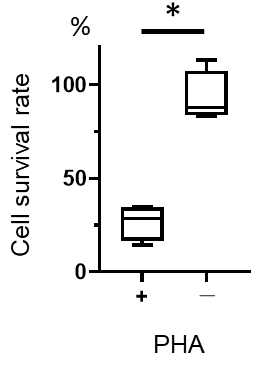
Figure 5. Cytotoxicity of T-01 against activated lymphocytes. Lymphocytes were isolated from the spleens of naïve mice, cultured in the presence or absence of PHA, and then infected with T-01. Cell survival was assayed 24 h after infection. The results are presented as boxplots, which display the dataset based on the five-number summary: minimum, maximum, sample median, and the first and third quartiles. The Student’s t -test was used to determine statistical significance (* p < 0.05). The experiments were performed four times. These data are the mean of 4 experiments.